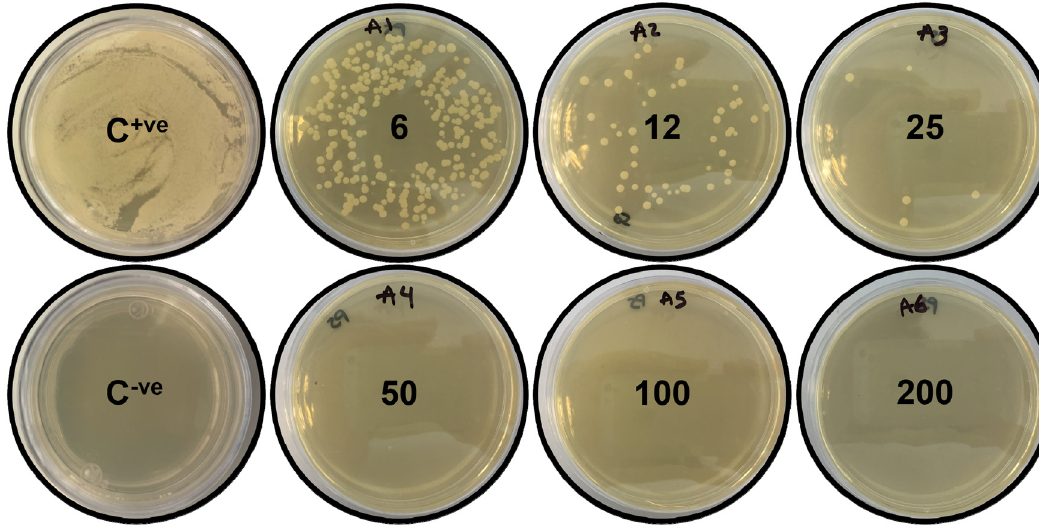
Figure 5: Shows the photos of Petri plates used for colony counting